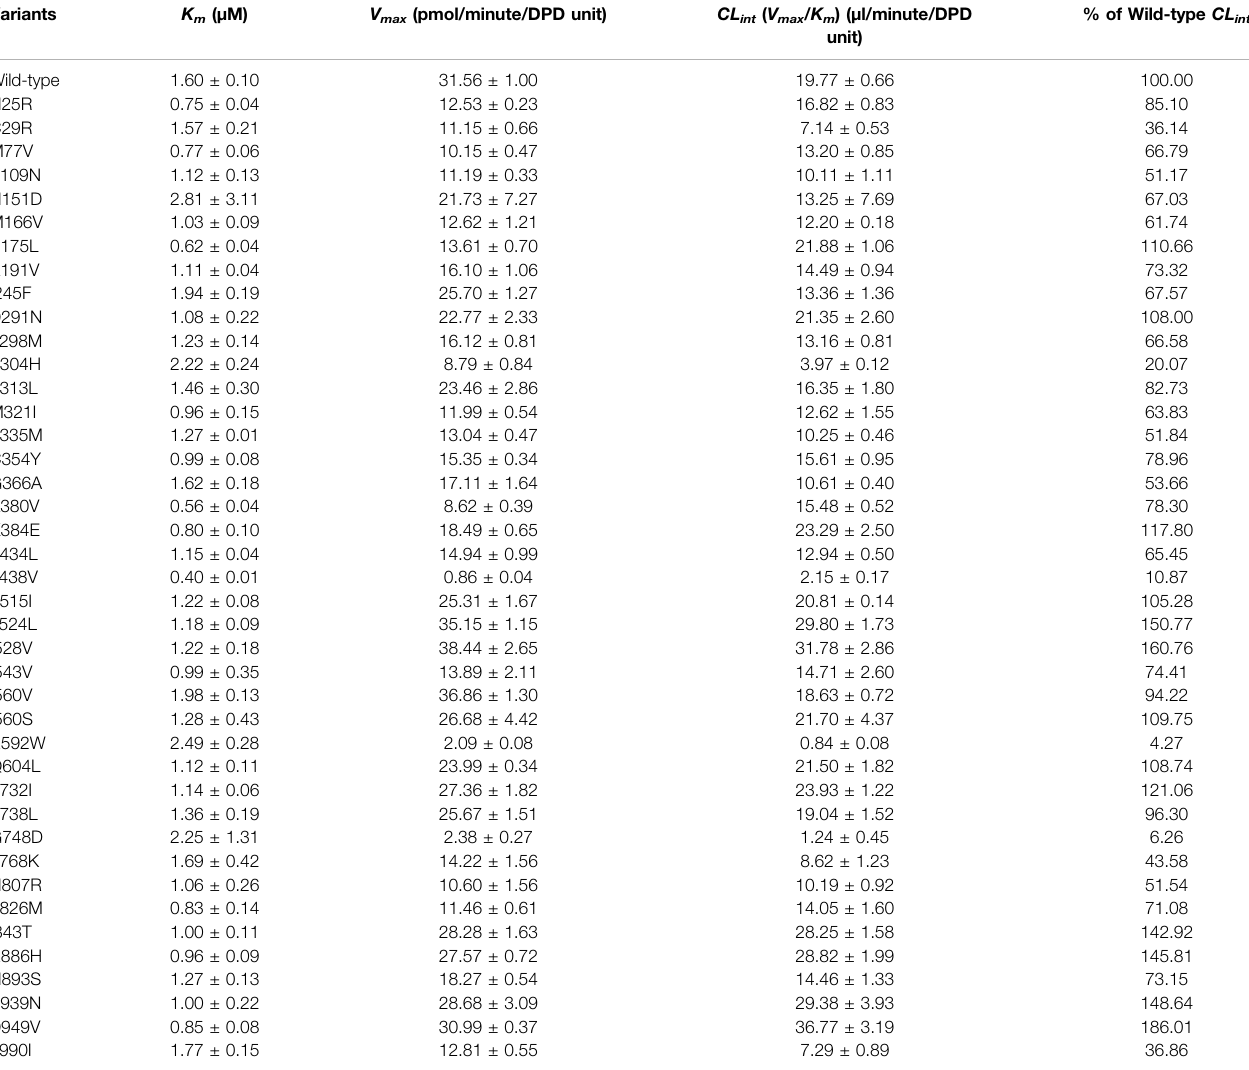
TABLE 4 | Kinetic parameters of dihydropyrimidine dehydrogenase (DPD) variants in 5-FU metabolism. Variants